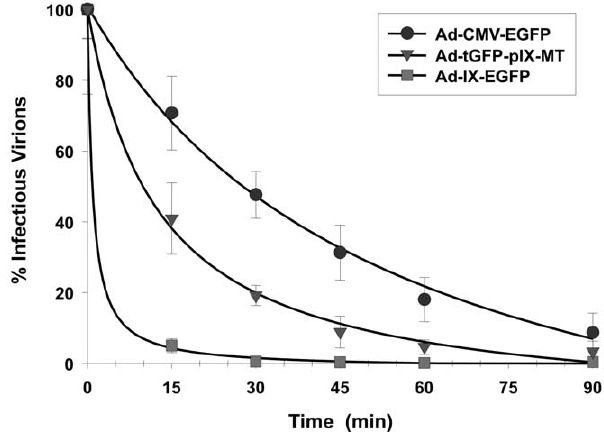
Figure 3. Thermostability of Ad-tGFP-pIX-MT compared to Ad- CMV-EGFP and Ad-IX-EGFP. The thermostability of each virus was determined by incubation at 45 u C for various times and quantified in terms of infectious titer. Each point represents the mean 6 SE of three replicate samples.